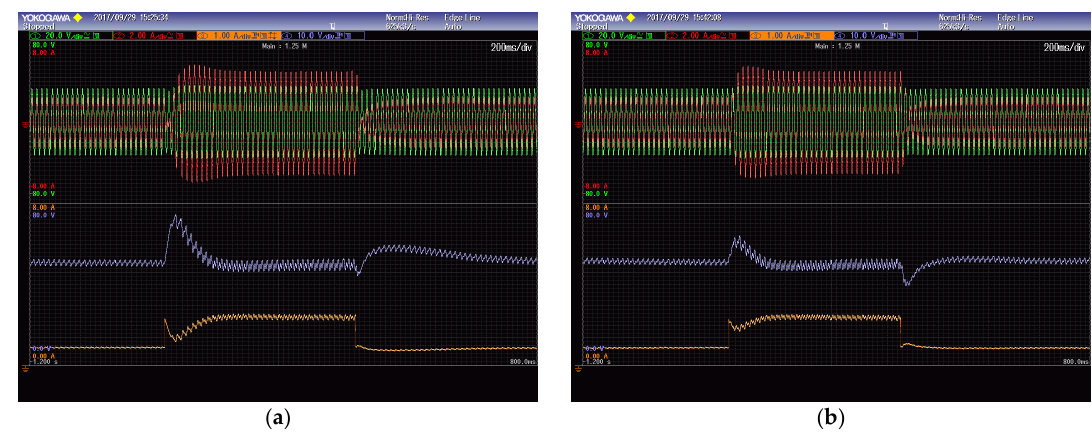
Figure 19. Experimental results of RCC-MPPT algorithms in case of step transients of R S : ( a ) low-pass filters by MAvg over T /2 (100 Hz) and ( b ) low-pass filters MAvg over T (50 Hz). Top traces: grid voltage and current. Bottom traces: PV voltage and current.